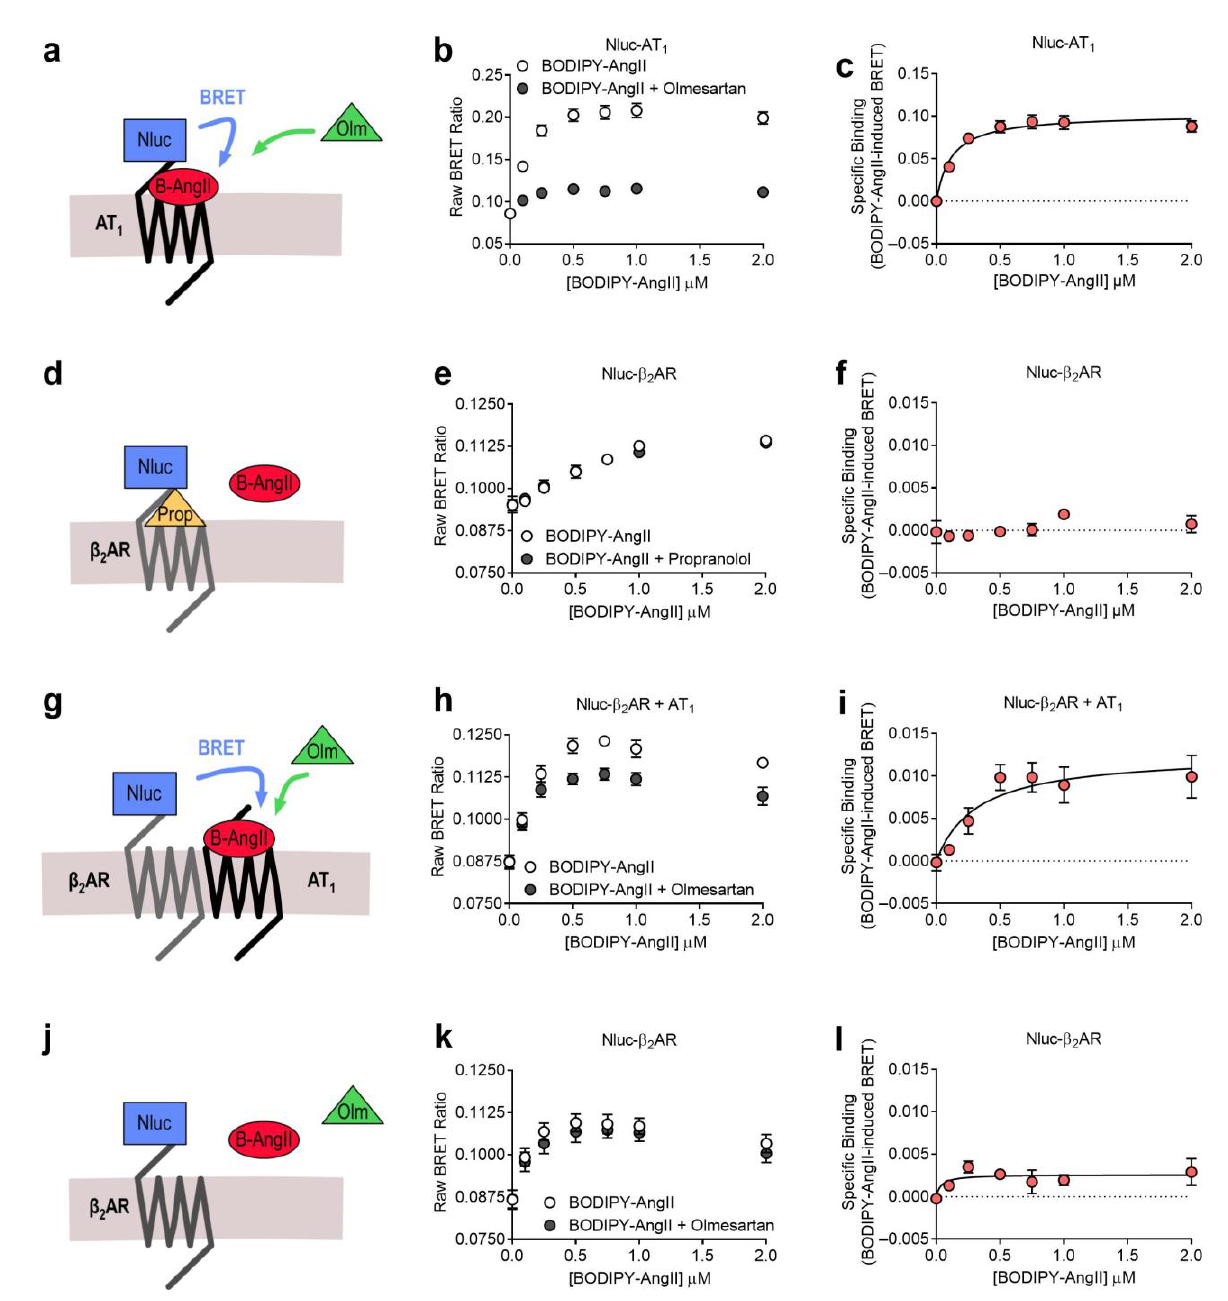
Figure 2. Saturation binding of BODIPY-AngII to the AT 1 receptor and the AT 1 - β 2 AR heteromer. Cells expressing Nluc-AT 1 ( a – c ) or Nluc- β 2 AR ( d – f , j – l ) or Nluc- β 2 AR + AT 1 ( g – i ) were treated with BODIPY-AngII (B-AngII) in the presence or absence of 1 µ M olmesartan (Olm; a – c , g – l ) or the presence or absence of 10 µ M propranolol (Prop; d – f ) to generate BODIPY-AngII total and non-specific binding data ( b , e , h , k ) and specific binding curves (where possible; c , f , i , l ). Data are displayed as the raw BRET ratio ( b , e , h , k ) or specific binding ( c , f , i , l ), mean ± SEM of three ( e , f ) or four ( b , c , h , i , k , l ) independent experiments.